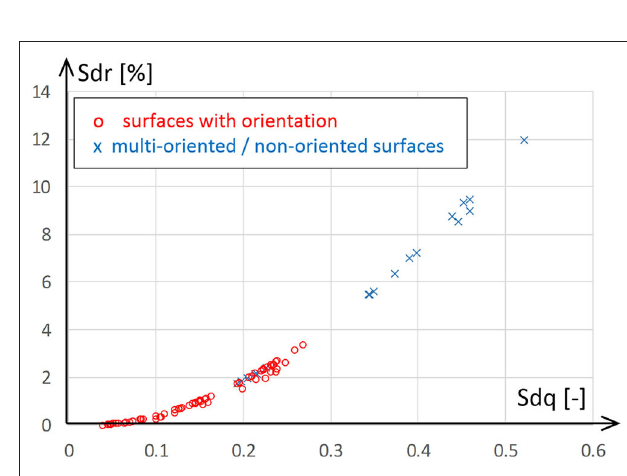
FIGURE 3 | Sdq-Sdr map for surfaces with orientation and multi-oriented/non-oriented surfaces.